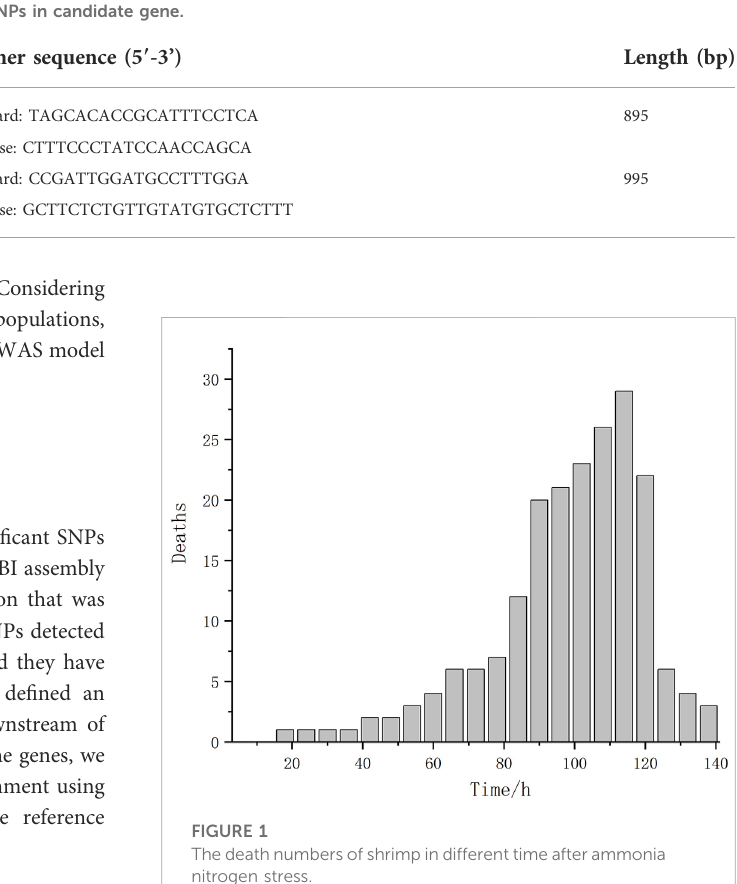
TABLE 1 The primers designed for the identi fi cation of SNPs in candidate gene.